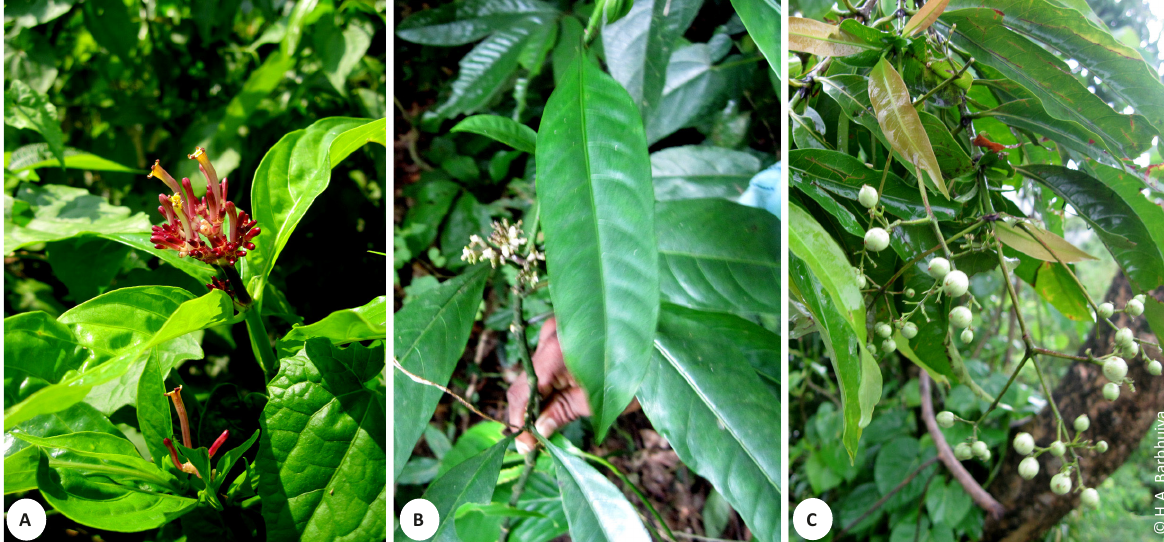
Regional Red List Category and Criteria: The Extent of occurrence is estimated to be ca. 15km 2 (Criteria CR B1<100km 2 ); The area of occupancy is estimated to be 8km 2 (Criteria CR B2˂10km 2 ), known to exist at only a single location (Criteria CR B2a). The population size is estimated to number less than 10 individuals and so far only one plant was seen (Criteria CR D˂50 mature individual), while there is degradation of the habitat (Criteria CR B2b(iii)) due to slash-and-burn cultivation and tree felling. Following the IUCN Red List Categories and Criteria (IUCN 2001), this species has been classified as Critically Endangered (CR). As there is no possibilities of rescue from neighboring regions, hence there is no change to the initial